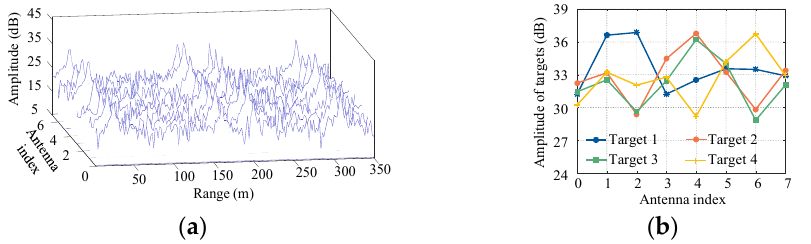
Figure 4. Amplitude of targets. ( a ) range-array 2D spectrum: ( b ) Target amplitudes in single range